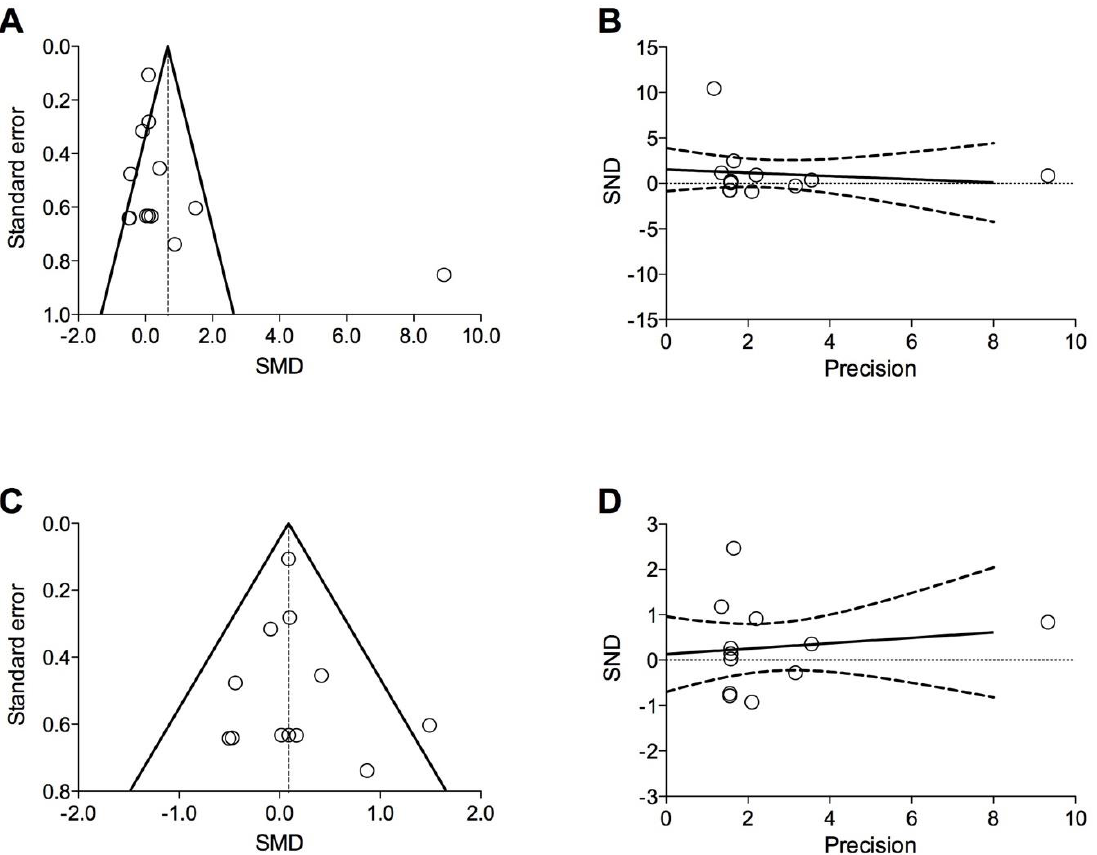
Figure 5. Funnel plot ( A , C ) and graphical representation of Egger’s test ( B , D ) for the overall impact of stem cell-based regenerative therapies and derived products vs. baseline or CTL on FEV 1 ( A , B ) and for the sensitivity analysis on FEV 1 vs. baseline or CTL ( C , D ). CTL: control; FEV 1 : forced expiratory volume in the 1st second; SMD: standardized mean difference; SND: standard normal devia- tion.